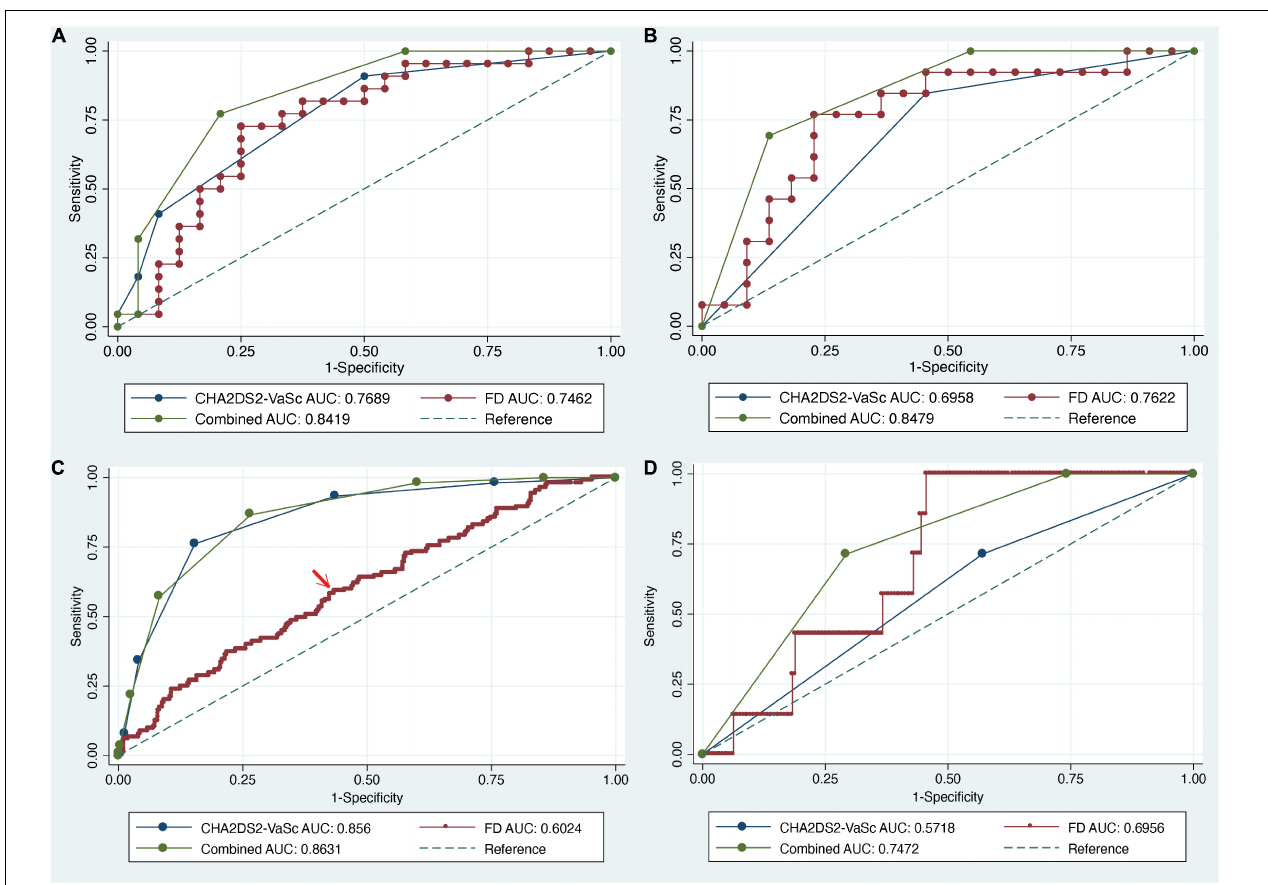
FIGURE 4 | ROC analysis of FD and CHA 2 DS 2 -VaSc score in training and validation cohorts. (A) ROC curve for assessing the patients in the training cohorts. (B) ROC analysis of low- to moderate-risk patients with AF. Both AUC of FD and combined scoring system were significantly larger than that of CHA 2 DS 2 -VaSc score ( p = 0.005 and 0.001, respectively). (C) ROC analysis of FD and CHA 2 DS 2 -VaSc score among all patients in the validation cohort. (D) ROC analysis in low- to moderate-risk patients in the validation